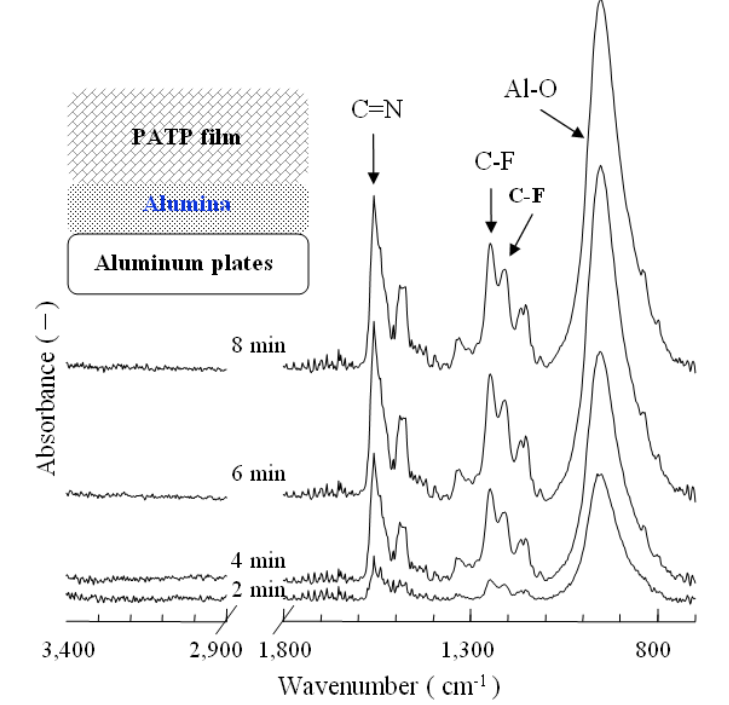
Figure 1. FT-IR spectra of polymeric films obtained by the polymerization of ATP( Resolution: 4 cm − 1 ; Incident angle: 80°; Scan times: 128 times).